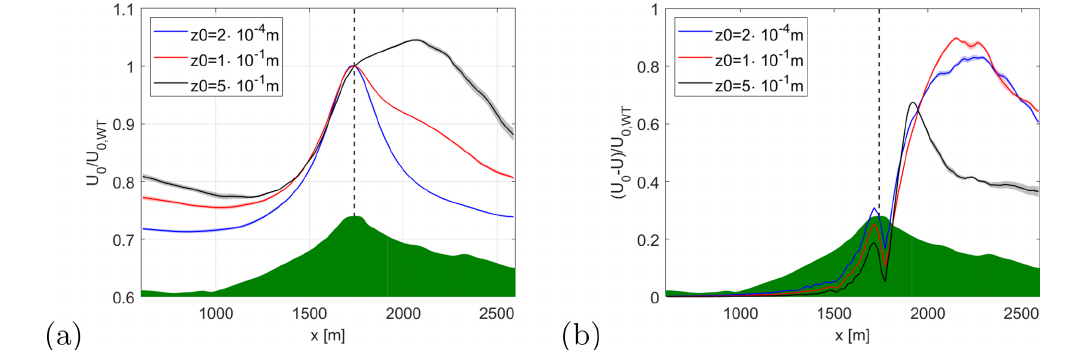
Figure 3. Free-stream velocity (a) and induced velocity (b) along the centreline of the turbine at different roughness heights. The velocities are scaled with the free-stream velocity at the position of the wind turbine. The shaded area indicates the standard deviation of the mean. The vertical dashed line indicates the position of the